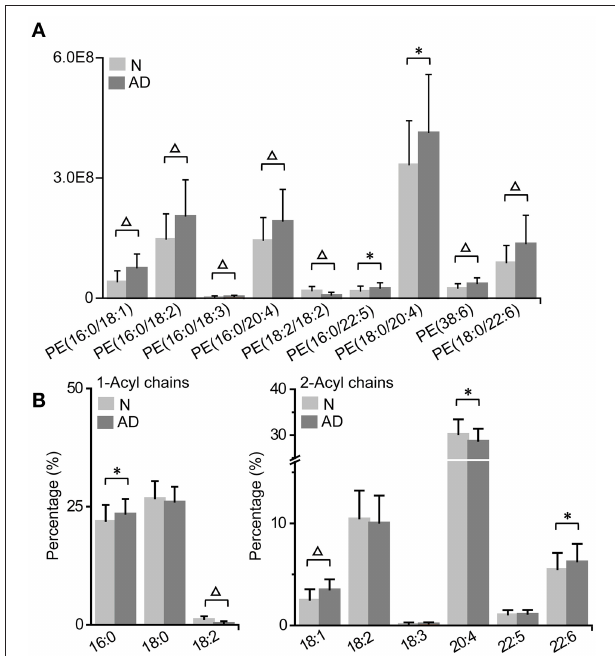
FIGURE 5 | Characteristic PE accumulation (A) and its acyl chain alterations (B) in patients with AD. The column denotes the mean plus standard deviation. n = 32 and 35 in the normal (N) and AD group, respectively. * P < 0.05; 1 P < 0.01, two-tailed Mann-Whitney U test. (A) The relative abundances of lipids were used for the